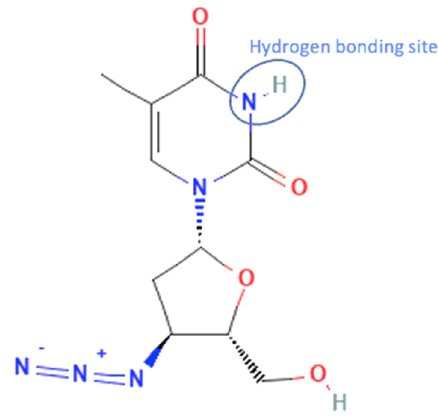
Figure 5. Molecular structure of zidovudine and its interaction site [133].